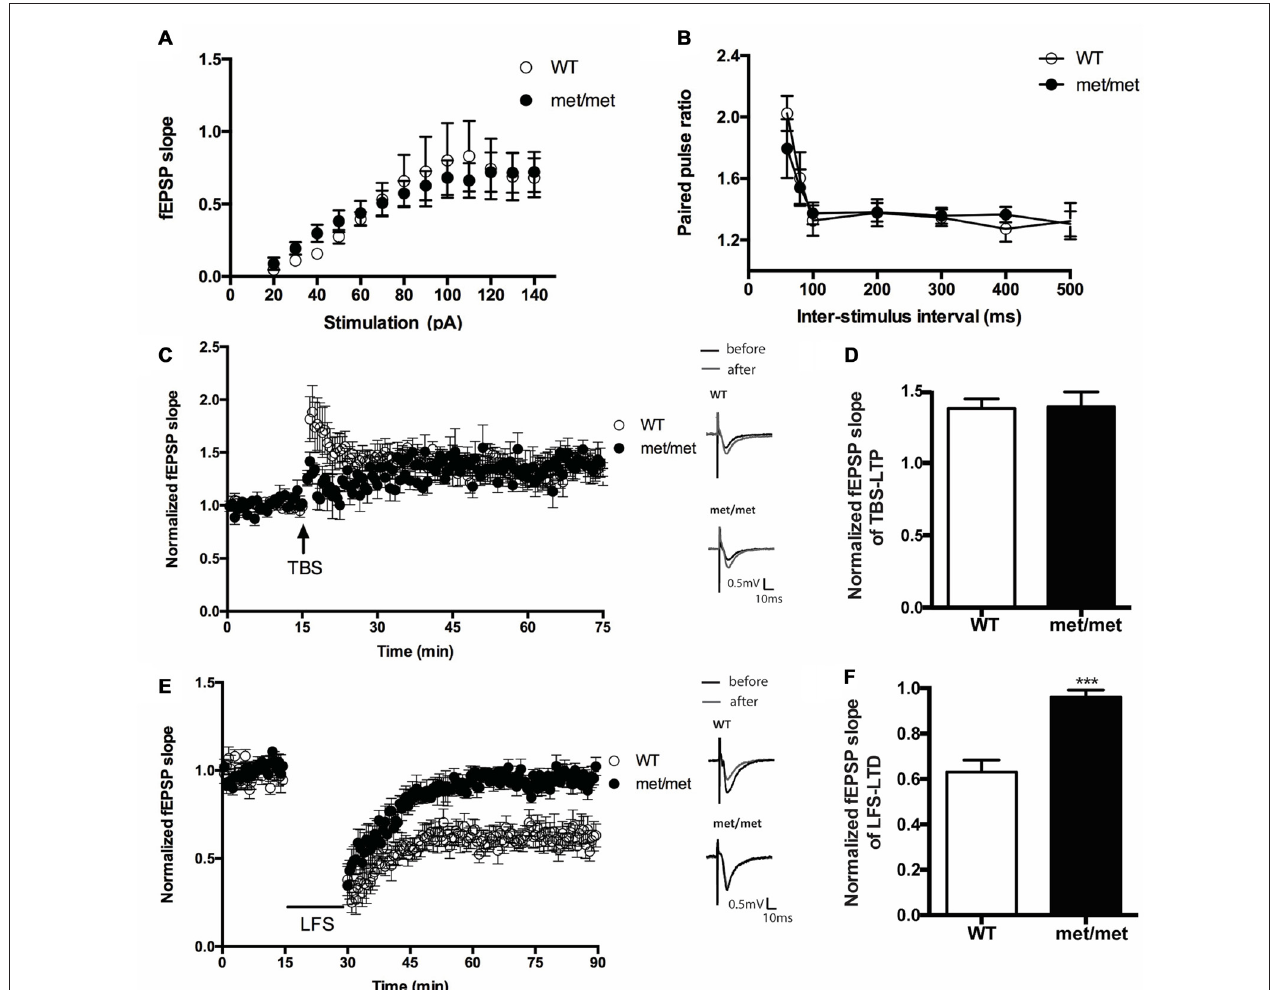
FIGURE 3 | Hippocampal low frequency stimulation (LFS)-long-term depression (LTD), but not basal transmission and theta burst stimulation (TBS)-LTP, was impaired in BDNF Met / Met mice. (A) Input-output curve (WT: N = 7 from four mice; BDNF Met / Met : N = 7 from four mice; P = 0.9758). (B) Pair-pulse ratio (WT: N = 6 from three mice; BDNF Met / Met : N = 10 from five mice; P = 0.8601). (C) TBS-induced CA3-CA1 LTP. Insert in (C) : typical field excitatory postsynaptic potential (fEPSP) recordings were shown before TBS (black) or 60 min after LTP induction (gray). (D) Summary of the data showed the magnitude of LTP. ( N = 7 for WT; N = 5